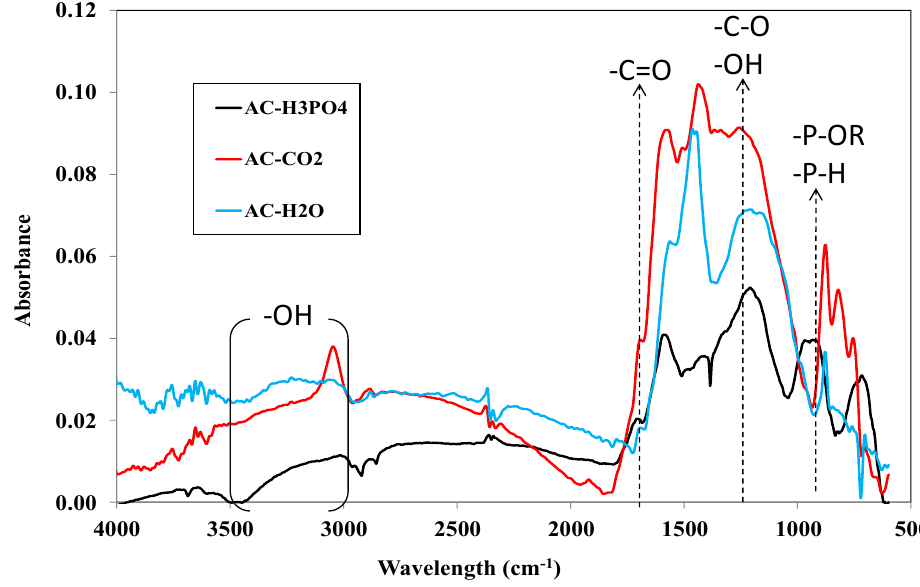
Figure 5. Fourier transform infrared spectroscopy (FTIR) spectra for the activated carbon samples.